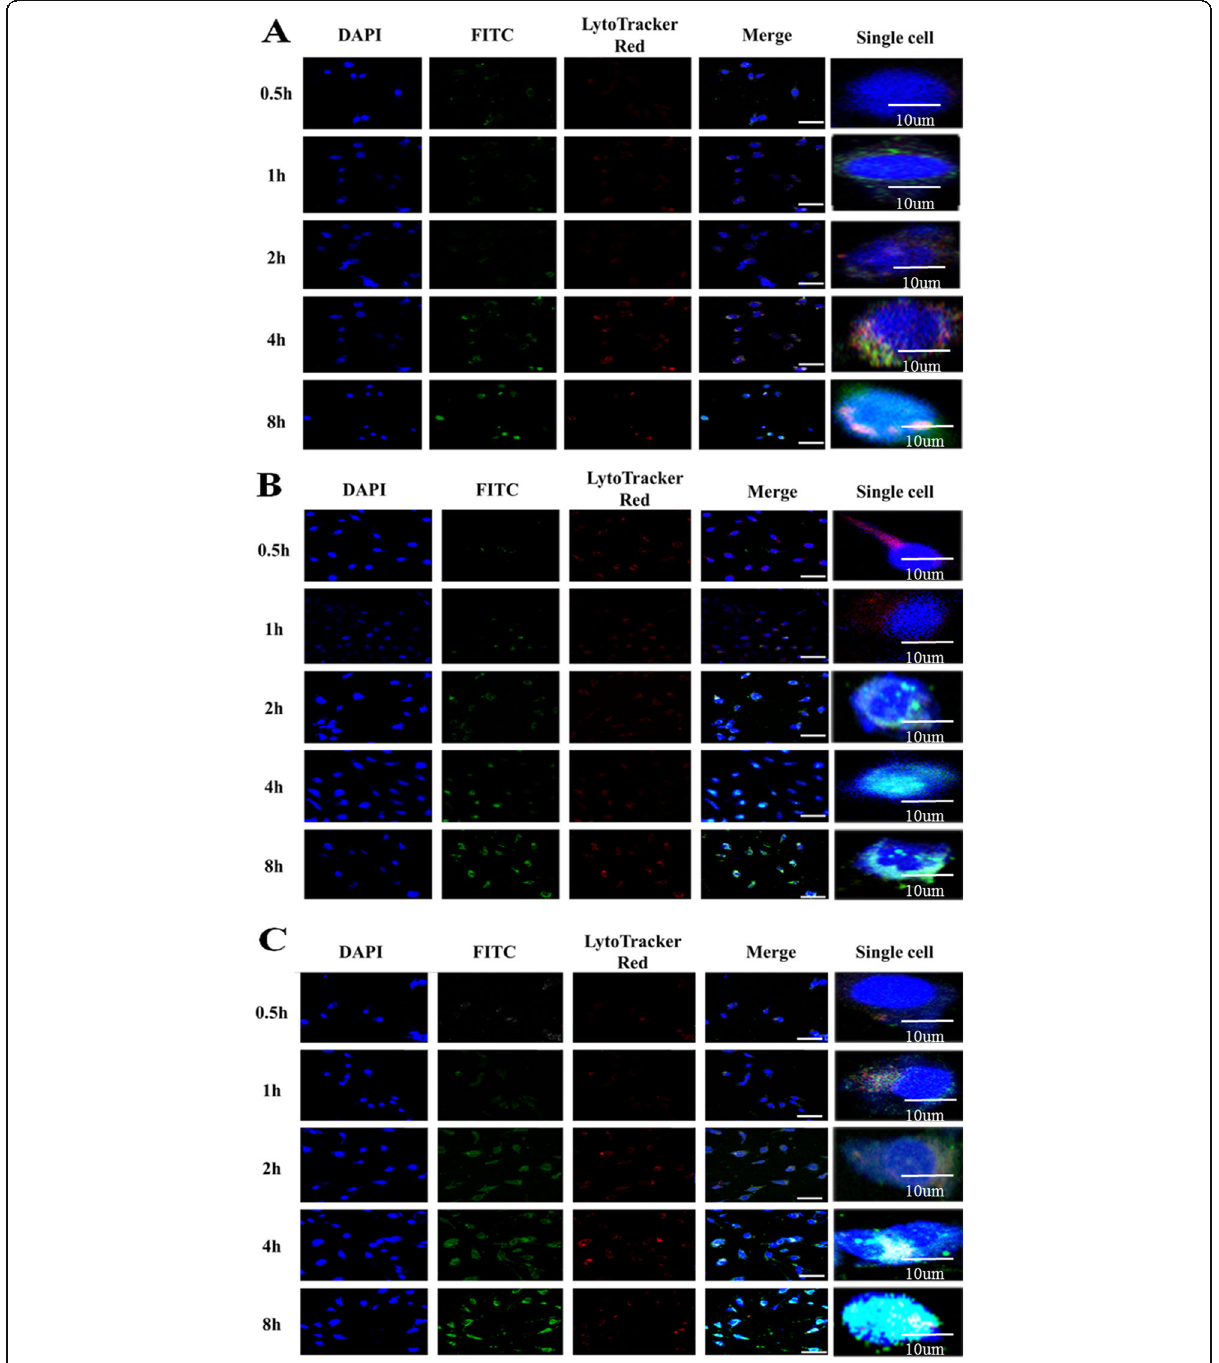
Fig. 5 Cellular internalization and lysosomal escape of PEG-GO-PEI-FA observed by CLSM. SKOV3 ovarian cancer cells incubated with a PEI, b PEG- GO-PEI-FA, and c PEG-GO-PEI-FA for 0.5, 1, 2, 4, and 8 h. Those in blue were nuclei stained with DAPI, green were nanocomplexes labeled with FITC, and those in red represented endosomes and lysosome fluorescence after staining with LysoTracker red. Scale bars represent 100 μ m, but the scale bar is 10 μ m in single